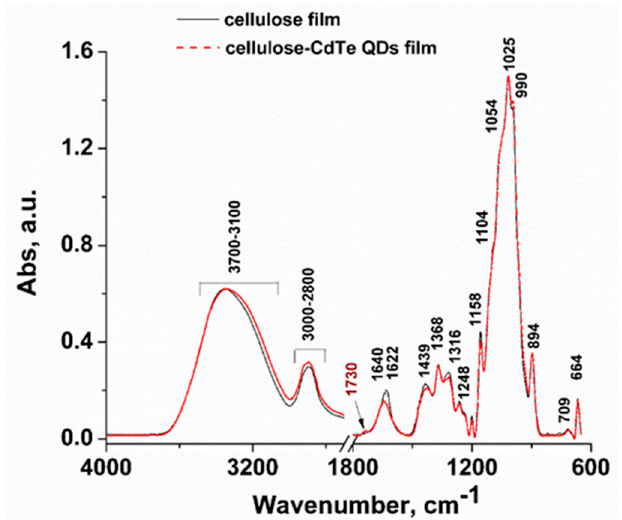
Figure 4. Fourier transform infrared (FTIR) spectra of cellulose and cellulose-CdTe QDs films.